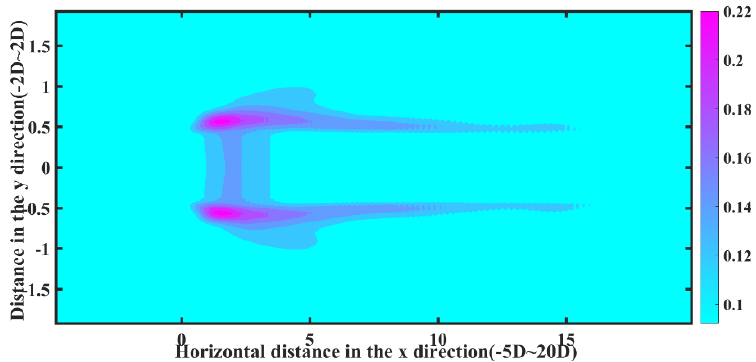
Figure 14. Distribution of turbulence intensity on the z = 0 plane.